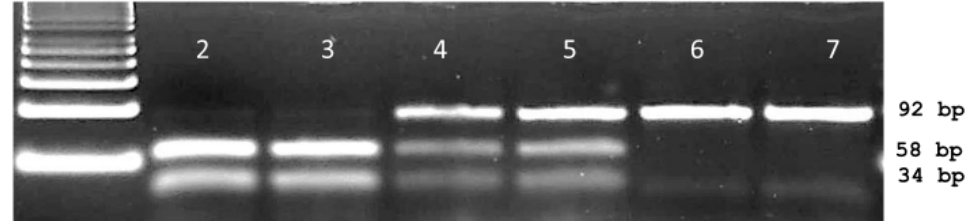
Figure 3. Typical dPACS profiles for wild and I2041N mutant ACCase Lolium multiflorum